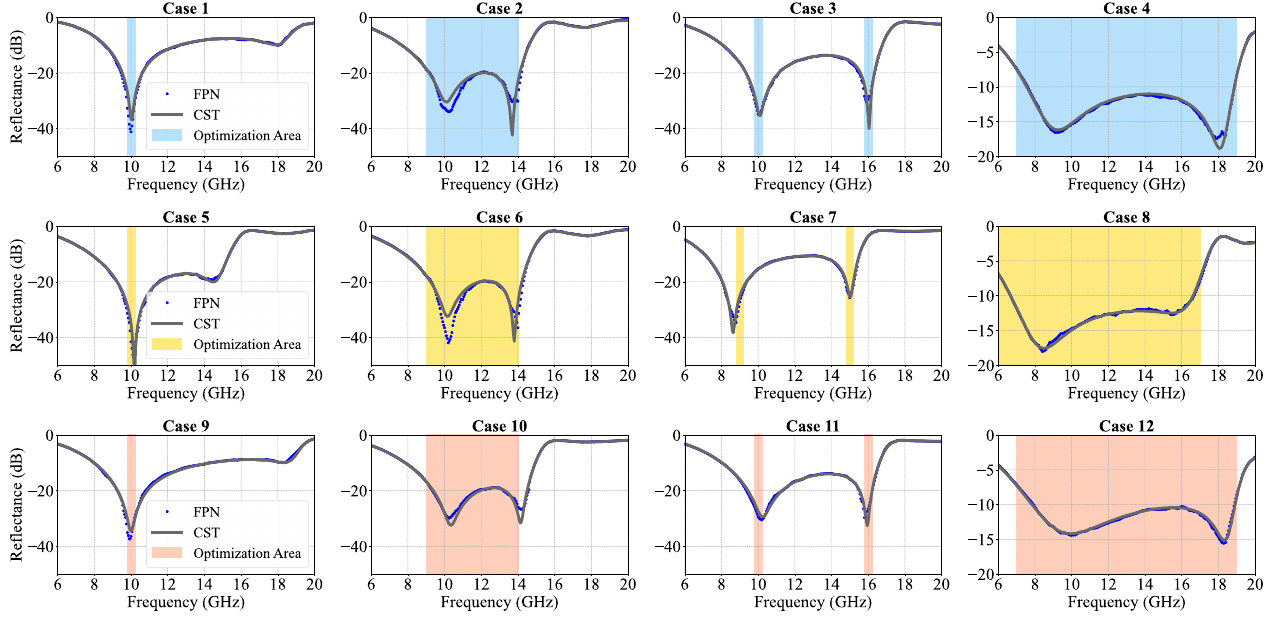
Figure 6. Versatile absorber designs based on different requirements. (The reflectance are shown in logarithmic coordinate) Cases 1–4: inverse design in all five degree of freedom. Cases 5–8: inverse design with thickness of substrate h fixed at 3.5 mm. Cases 9–12: inverse design with sheet resistance of graphene R g fixed at 250 Ω . The colored area is the optimization area. FPN indicates the optimized reflection spectra given by inverse design system while CST represents the reflection spectra from CST simulations with the optimized parameter